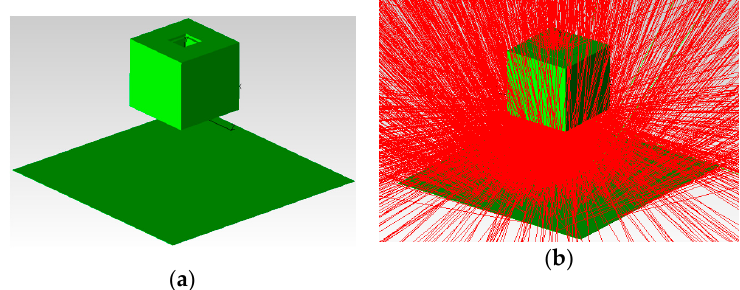
Figure 6. The simulation process of the uniform surface light source using Tracepro. ( a ) The simulation scenario; ( b ) The result after ray tracing.